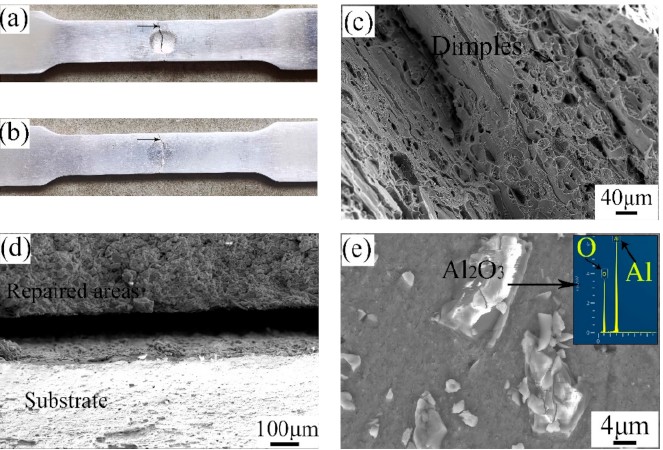
Figure 7. Fracture morphologies of the ( a , c ) UR samples and ( b , d , e ) CS samples.